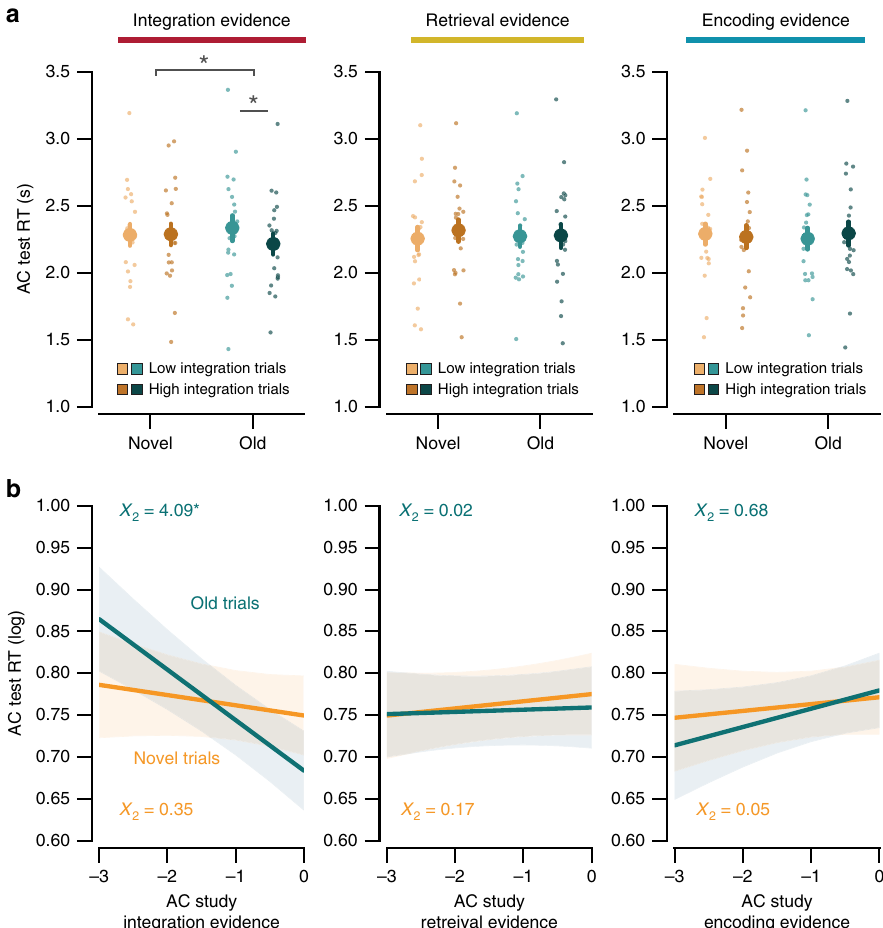
Fig. 4 Integration during learning predicts resistance to interference. a Reaction times (RTs) during AC Test as a function of evidence from the memory state classi fi er during AC Study. Novel and Old AC Study trials were median split based on classi fi er evidence (high vs. low) for integration (left column), retrieval (middle column), and encoding (right column). There was a selective relationship between integration evidence and RTs in the Old condition ( p = 0.031), re fl ecting less interference (faster RTs during AC Test) for high compared to low integration during AC Study. Thus, integration speci fi